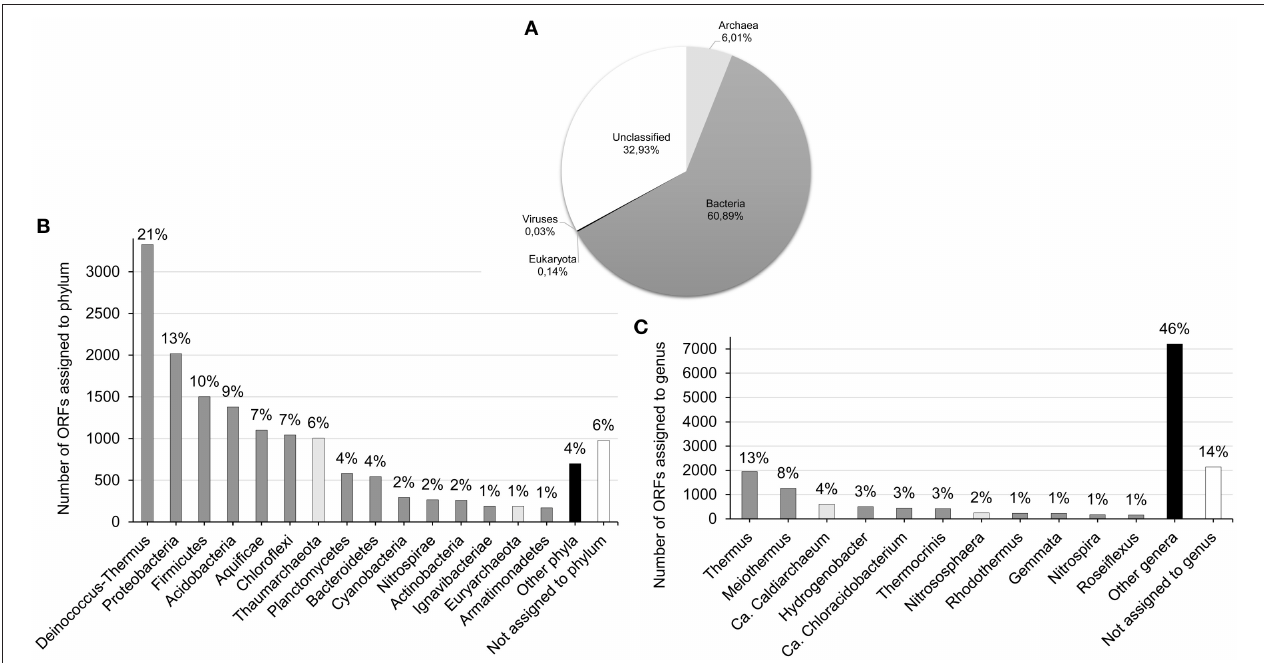
FIGURE 2 | Taxonomic classification of ORFs predicted from contigs. (A) All ORFs ( n = 23.207 ) predicted from contigs ( ≥ 500bp) at the superkingdom level. Predicted ORFs were compared using BLAST to the NCBI protein database and assigned to taxa using MEGAN with a minimum bit-score of 100 and e-value 1e-05. Over 67% (15,565) ORFs were assigned to Bacteria, Eukaryota, Achaea, and Viruses, while < 33% remained unclassified. (B) ORFs assigned at the phylum level. Of 15,557 ORFs assigned by MEGAN to Bacteria, Eukaryota, and Achaea, 14,577 (94%) could be classified at the phylum level. Bacterial phyla are colored in dark gray and achaeal are represented by light gray bars. Phyla with abundance < 1% were collapsed into the “Other phyla” category (black bar). (C) ORFs assigned at the genus level. Of 15,557 ORFs assigned by MEGAN to Bacteria, Eukaryota, and Achaea, 13,419 (86%) could be classified at the genus level. Bacterial genera are colored in dark gray and archaeal are represented by light gray bars. Genera with abundance less < 1% were collapsed into the “Other genera” category (black bar).